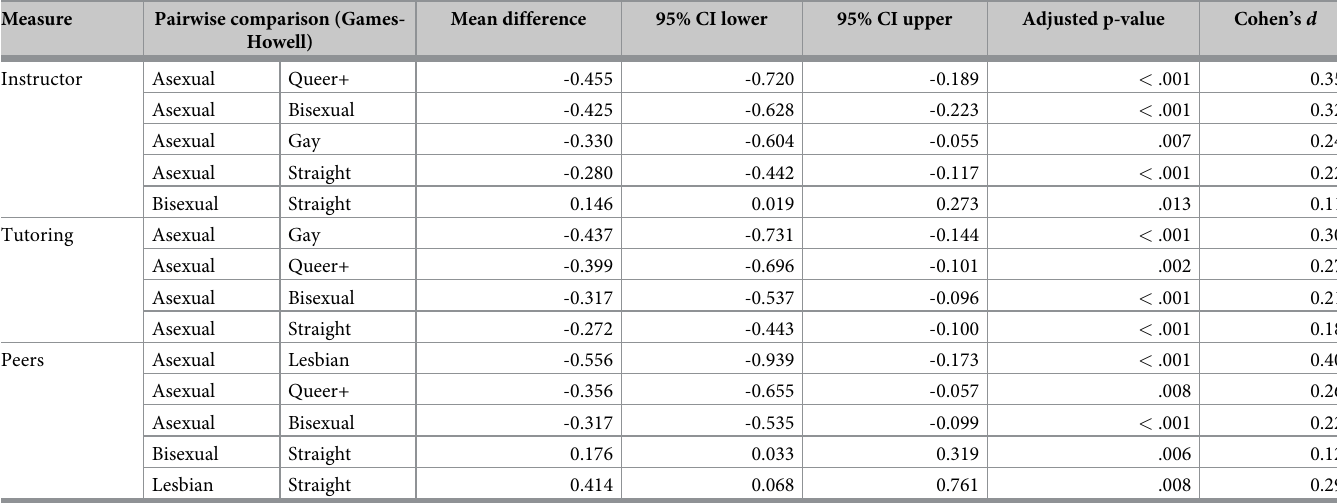
Table 5. Significant post hoc test of external-classroom attendance in math learning environments and sexuality. Measure